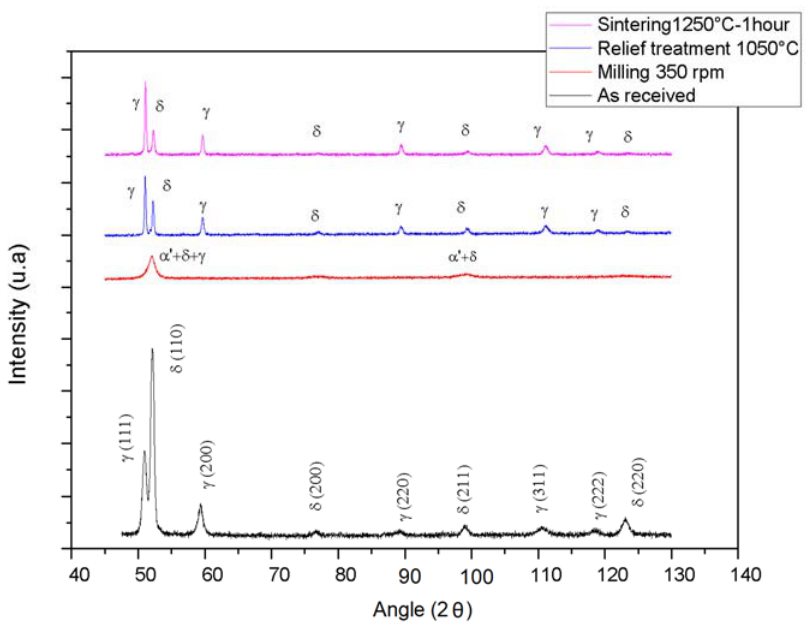
Figure 9. X-ray diffraction of stainless–steel under the following conditions: ( a ) as received ( b ) Milled at the time of 50 h ( c ) after tension relief treatment of the powder and ( d ) Sintered at 1250 °C for 1 h.